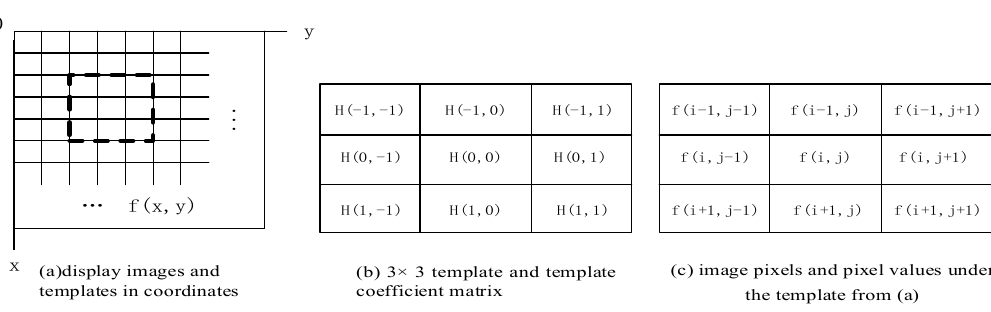
Figure 10. Schematic diagram of the template matching mechanism.